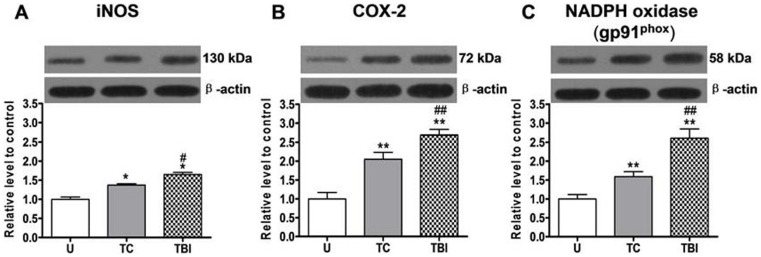
Expression of iNOS, COX-2 and NADPH oxidase (gp91phox) in leukocyte homogenates.From uninjured (U), trauma controls (TC) and traumatic brain injury (TBI) subjects, expression of iNOS, COX-2 and NADPH oxidase (gp91phox) in leukocyte homogenates at 24 h after injury are determined by western blot assay. Upper blots are typical western blots of enzyme expression in each group. Lower blots are β-actin expression demonstrating equal protein loading of gels for each enzyme. Bottom bar graphs show quantification of expression by densitometry, with enzyme expression expressed as a percent of β-actin density ± SE (n = 5 all groups). iNOS, COX-2 and NADPH oxidase (gp91phox) expression in both TC and TBI subject was significantly increased, while the expression was greater after TBI than in trauma control subjects. **P<0.01; *P<0.05, significantly different from uninjured by Fisher’s protected t tests. ##P<0.01; #P<0.05, significantly different from trauma controls by Fisher’s protected t tests.